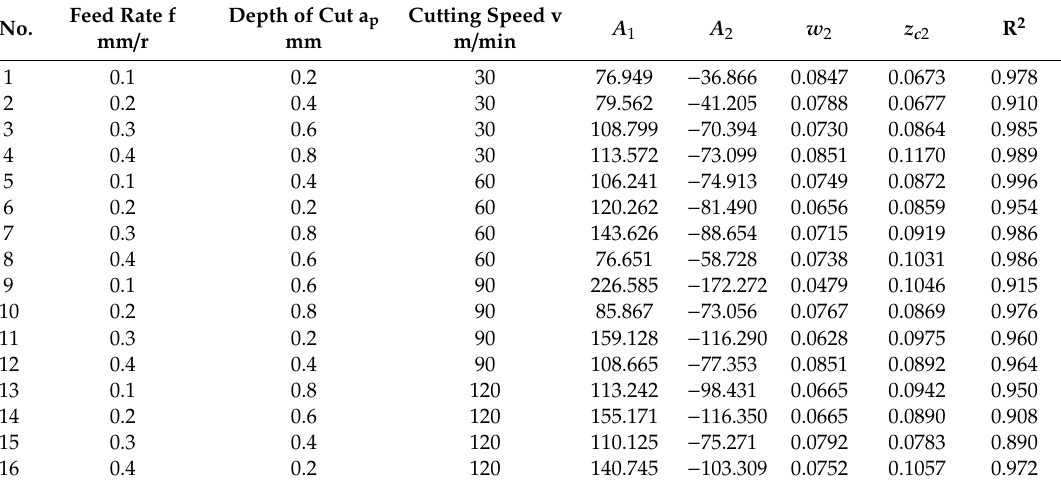
Table 5. Circumferential residual stresses fitting function coe ffi